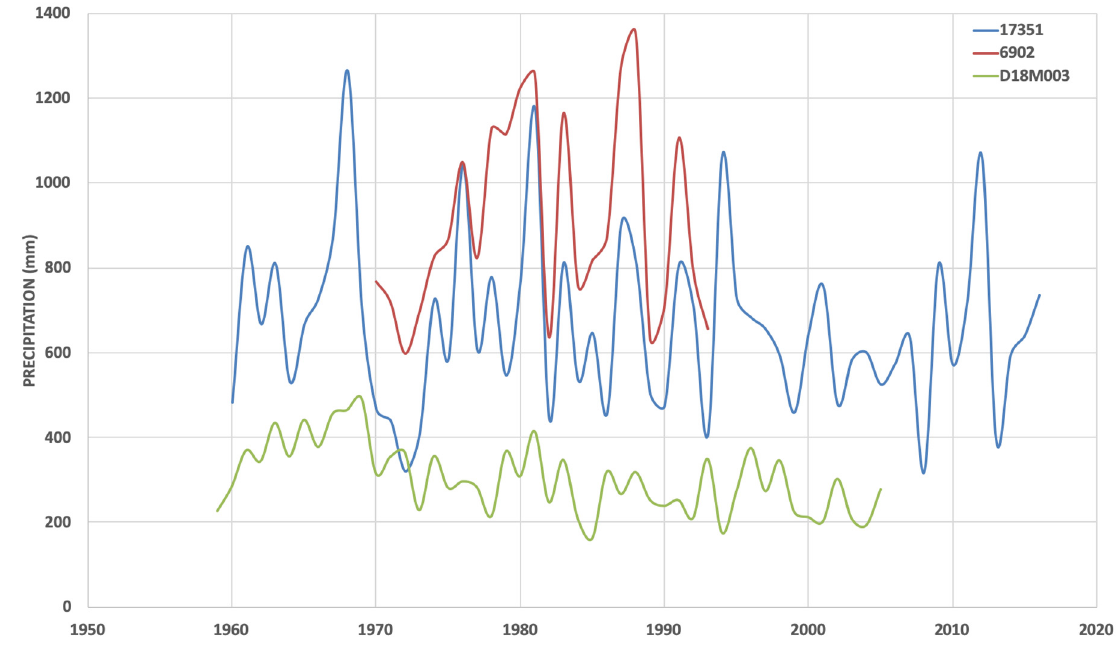
Figure 4. Temporal variability in precipitation.